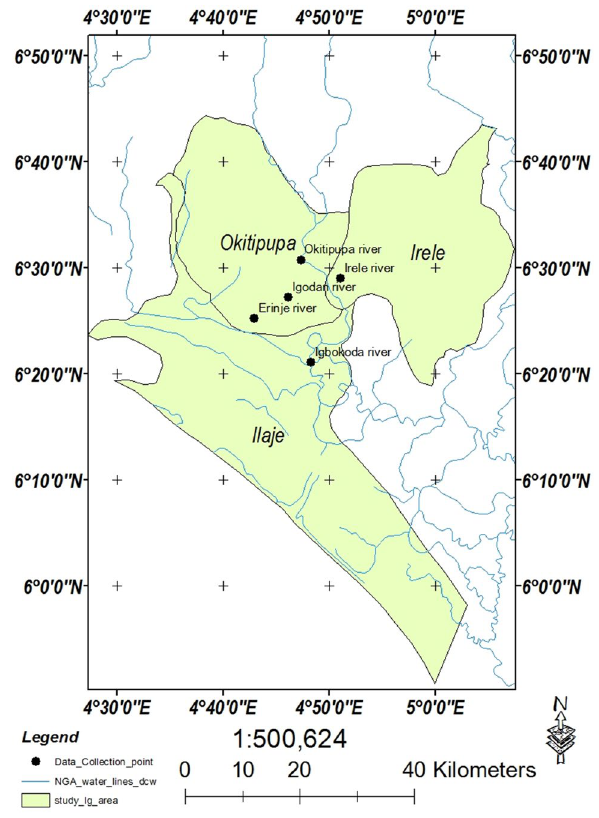
Fig. 1 A map showing the sampling